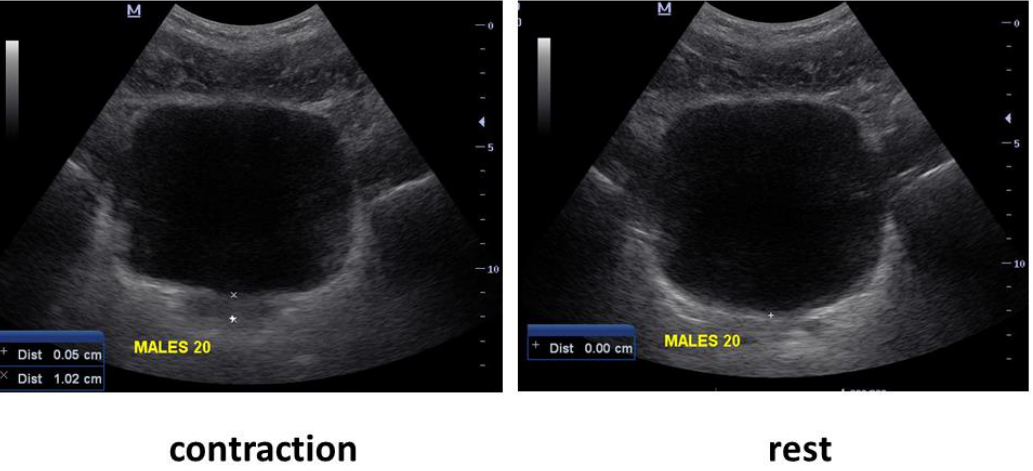
Figure 1. Ultrasound assessment of pelvic floor displacement at rest ( right ) and during contraction ( left ).